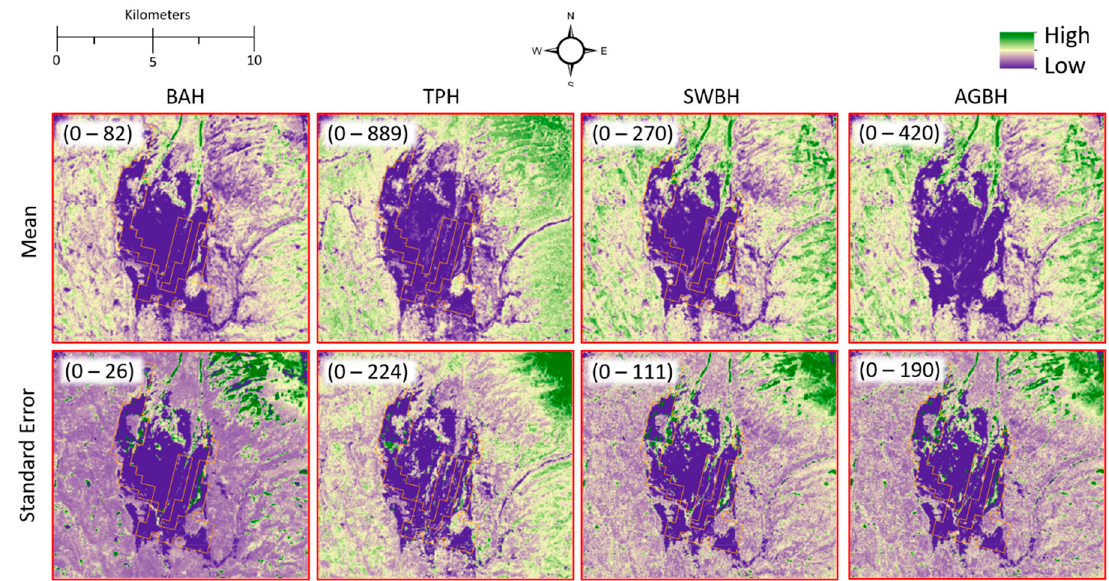
Figure 6. Raster surfaces depicting the spatial distribution of basal area ha − 1 BAH, tees ha − 1 (TPH), stem wood biomass ha − 1 (SWBH), and above ground biomass ha − 1 (AGBH) cell mean and standard error estimates for the same region identified in Figure 5. Low to high values for each graphic color ramp are displayed within the parentheses in the top left corner of each graphic. Table 7. Ensemble of generalized additive models (EGAM) predictor variables and fit statistics using all observations. Root mean squared error and overall map accuracy are reported for con- tinuous (a) and categorical (b) response variables.